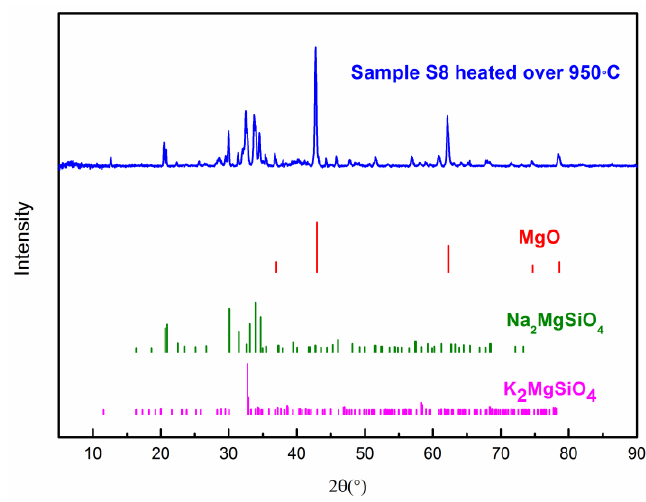
Figure 9. TG curve of the composite PCM.